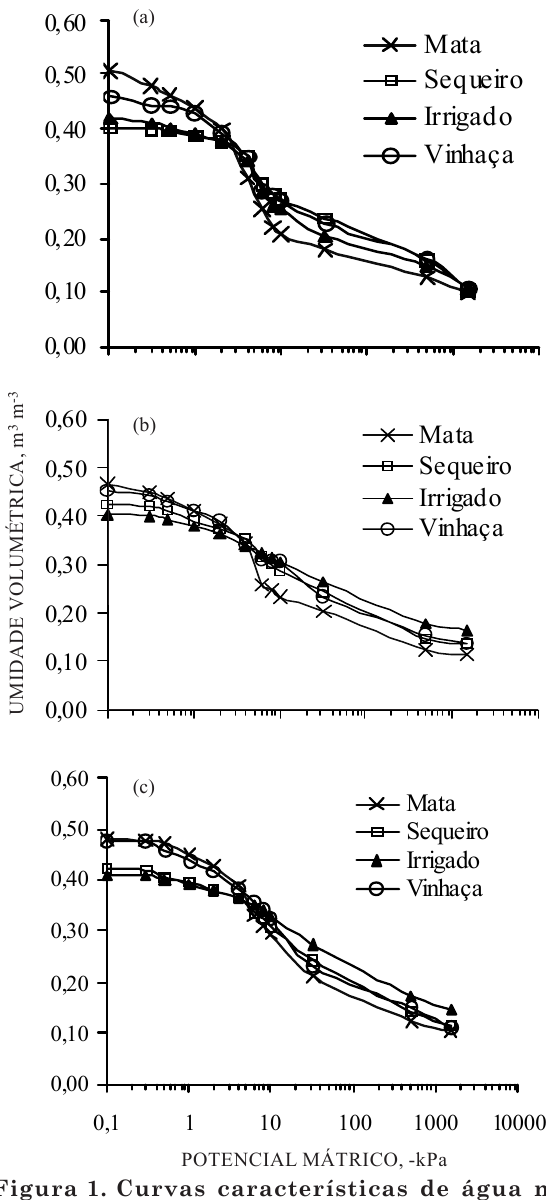
Figura 1. Curvas características de água nas camadas (a) 0–0,2 m, (b) 0,2–0,4 m e (c) 0,4–0,8 m para os sistemas de uso e manejo do solo